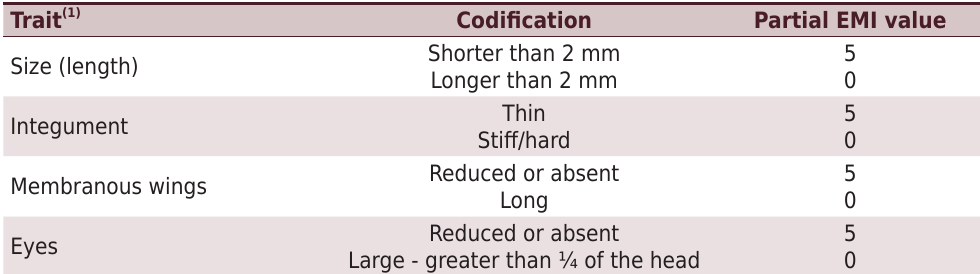
Table 2. Trait and score used to calculate the EMI value (ecomorphological index) for the discrimination of various Coleoptera morphotypes Trait